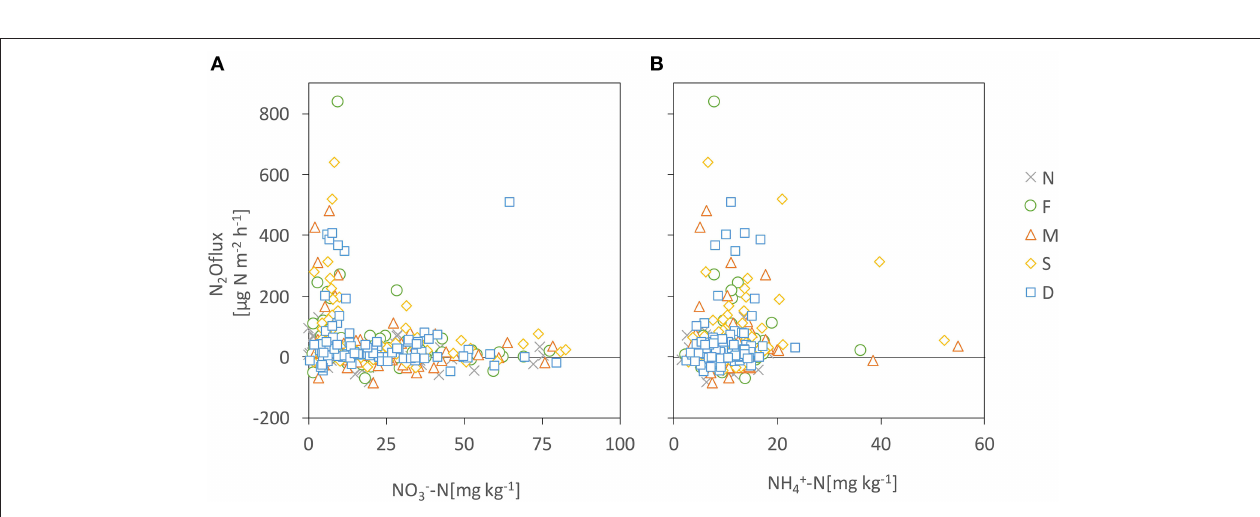
FIGURE 3 | Relationship between N 2 O flux and soil NO − 3 -N content (A) and NH + 4 -N content (B) . N is the no fertilizer plot, F is the chemical fertilizer plot, M is the manure plot, S is the slurry plot, and D is the digestive fluid